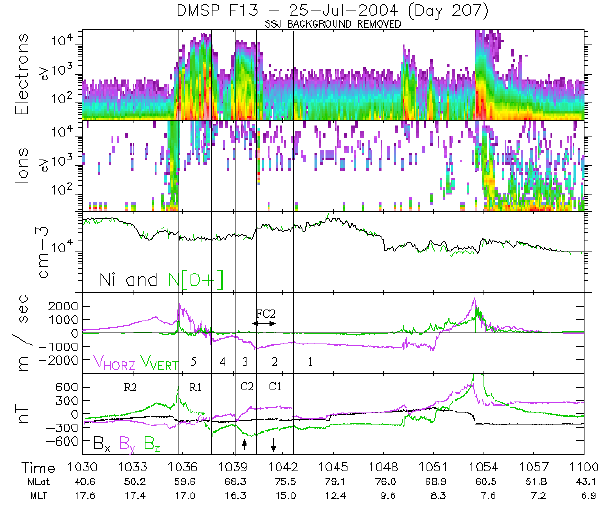
Fig. 10. DMSP F13 data obtained during the interval 10:30– 11:00UT on 25 July 2004. Panels from top to bottom shows (i) electron precipitation spectrogram (particle flux versus energy and time), (ii) ion precipitation flux, (iii) ion densities, (iv) cross track (violet trace) and vertical ion drifts, and (v) magnetic deflec- tion components B x , B y , and B z . Five regimes of different convec- tion/precipitation/Birkeland current configuration have been delim- ited by vertical